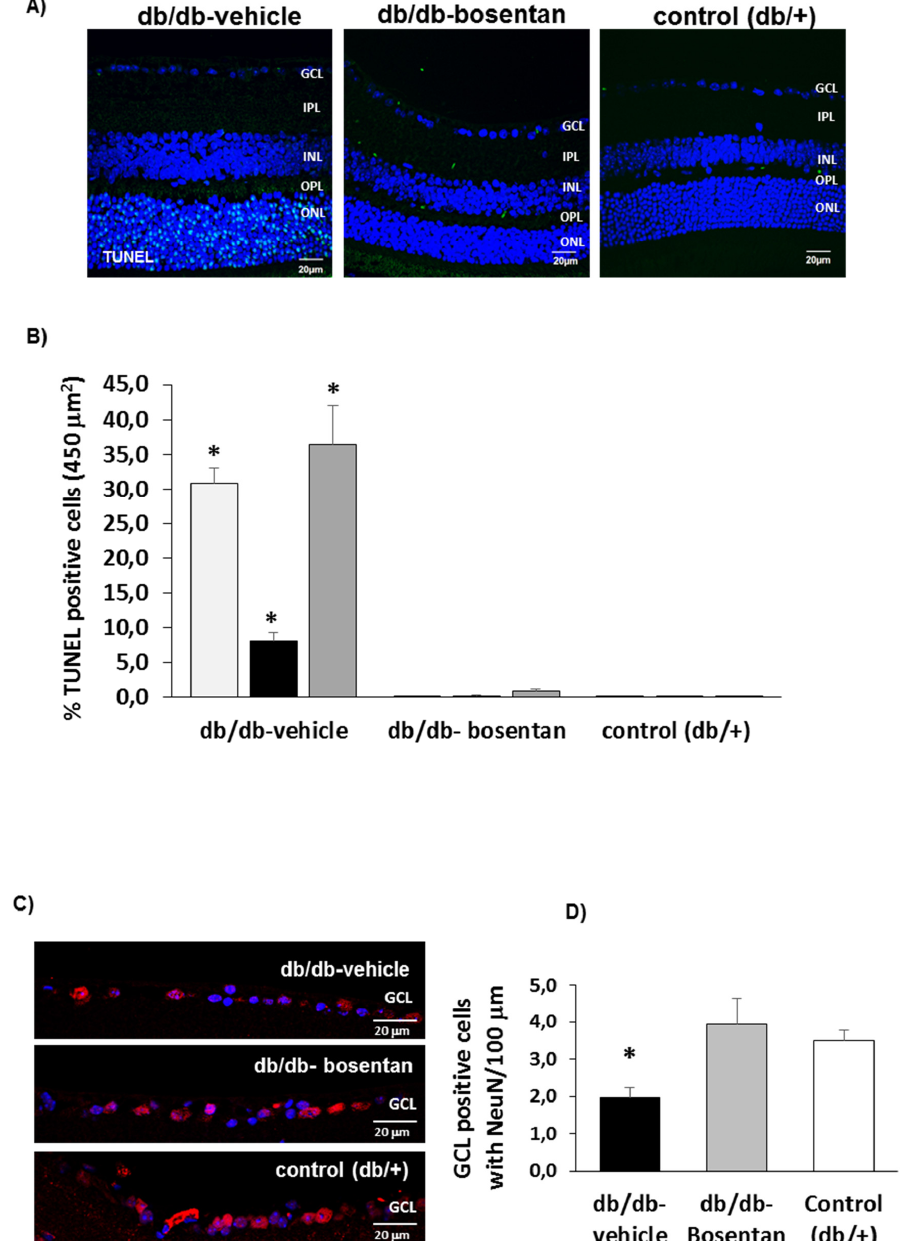
Figure 4. Apoptosis. ( A ) Comparison of TUNEL immunofluorescence (green) between representative samples from a db/db mouse treated with vehicle, a db/db mouse treated with bosentan and a non-diabetic mouse. Scale bar: 20 µ m; ( B ) Percentage of TUNEL positive cells in the retinal layers. * p < 0.001 in comparison with the other groups in all retinal layers (ONL, INL and GCL). n = 6 mice per group (10 sections per retina); ( C ) Comparison of NeuN positive cells (red) between representative samples from a db/db mouse treated with vehicle, a db/db mouse treated with bosentan and a non-diabetic mouse. Nuclei were labeled with DAPI (blue). Scale bar: 20 µ m; ( D ) Quantification of NeuN positive cells. * p < 0.05 when compared db/db mice treated with vehicle and either db/db mice treated with bosentan and non-diabetic